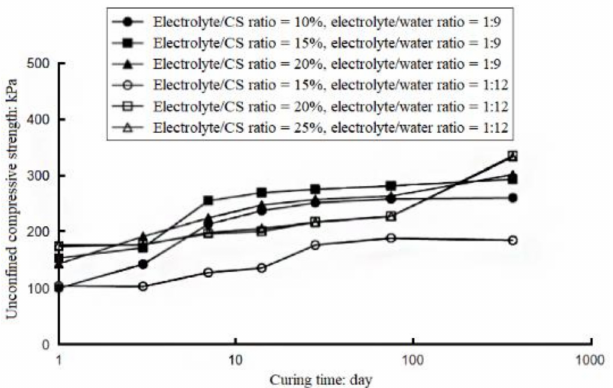
Figure 1. The relationship between UCS of colloidal-silica-treated soil and curing time [14]. Since gelatinized CS is a network composed of particle chains [19,20], the pores in the treated soil are occupied by silicon particles and gel chains, which make the